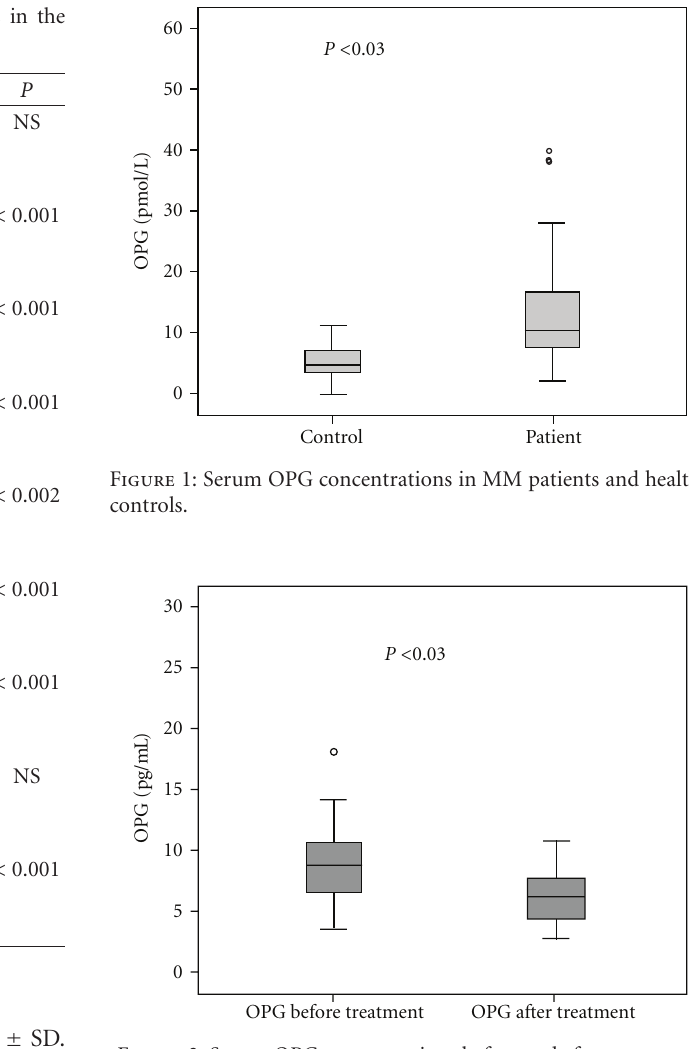
were also increased in patients compared to controls, whereas sRANKL/OPG ratio did not show significant di ff